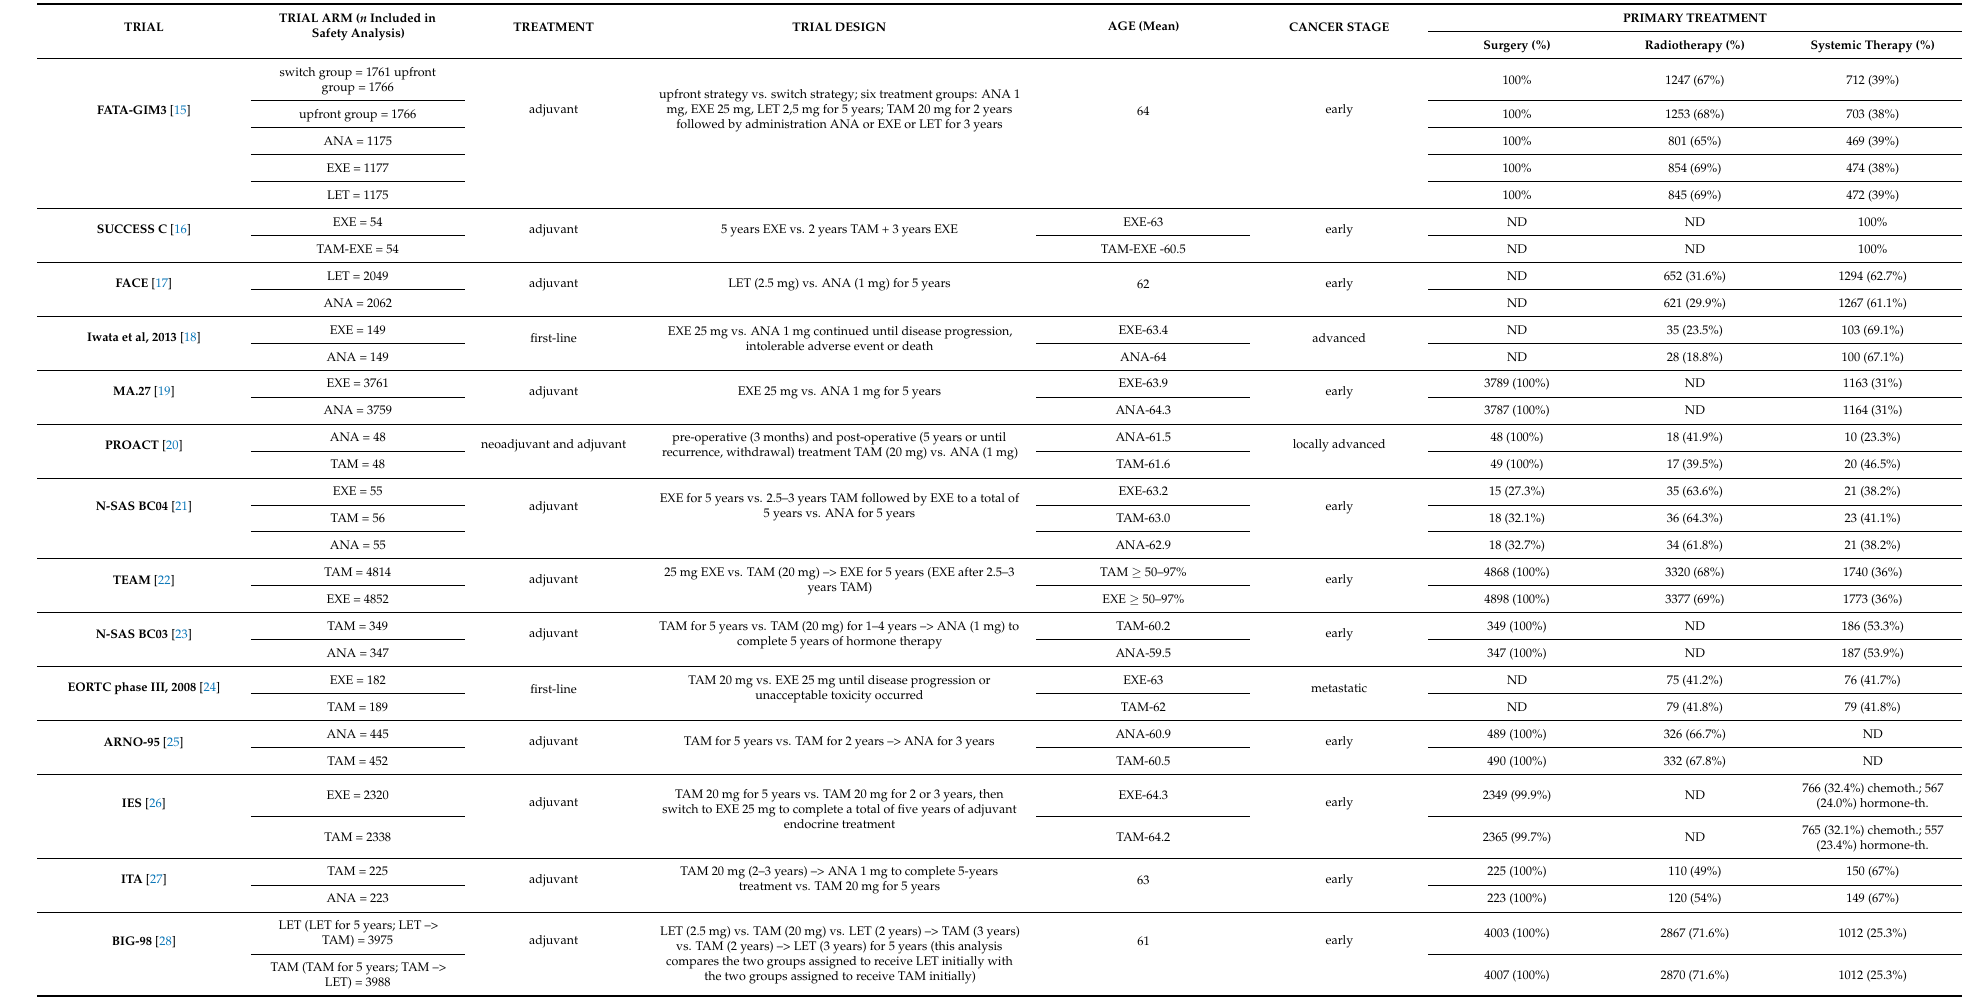
Table 1. Description of included studies. Legend: TAM—tamoxifen, EXE—exemestane, LET—letrozole, ANA—anastrozole, PBO—placebo, comb—combination, observ—observation, ND—no